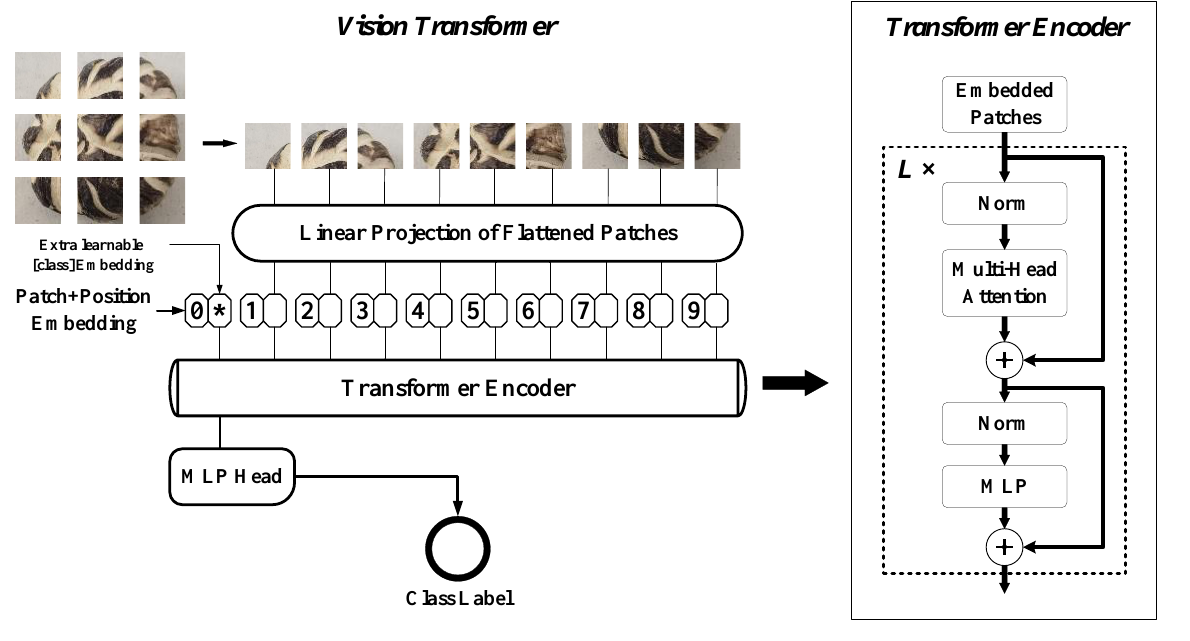
Figure 6. Structure of Vision Transformer.